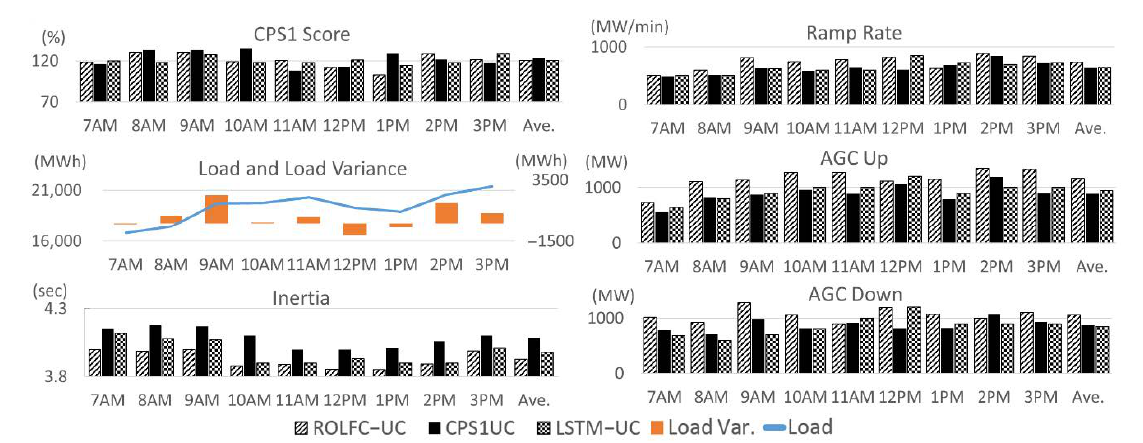
Figure 11. Comparisons of scheduling results by three different model-based UCs during the daytime period.